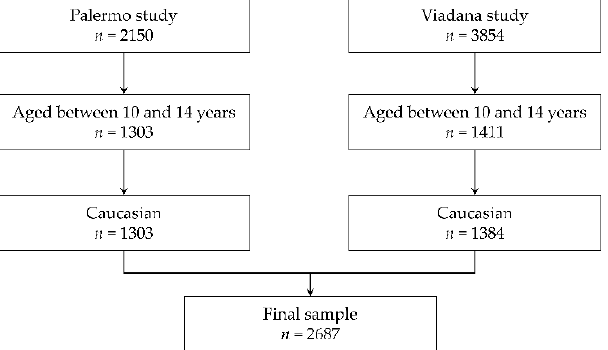
Figure 1. Flow diagram of the sample selection process based on exclusion criteria.